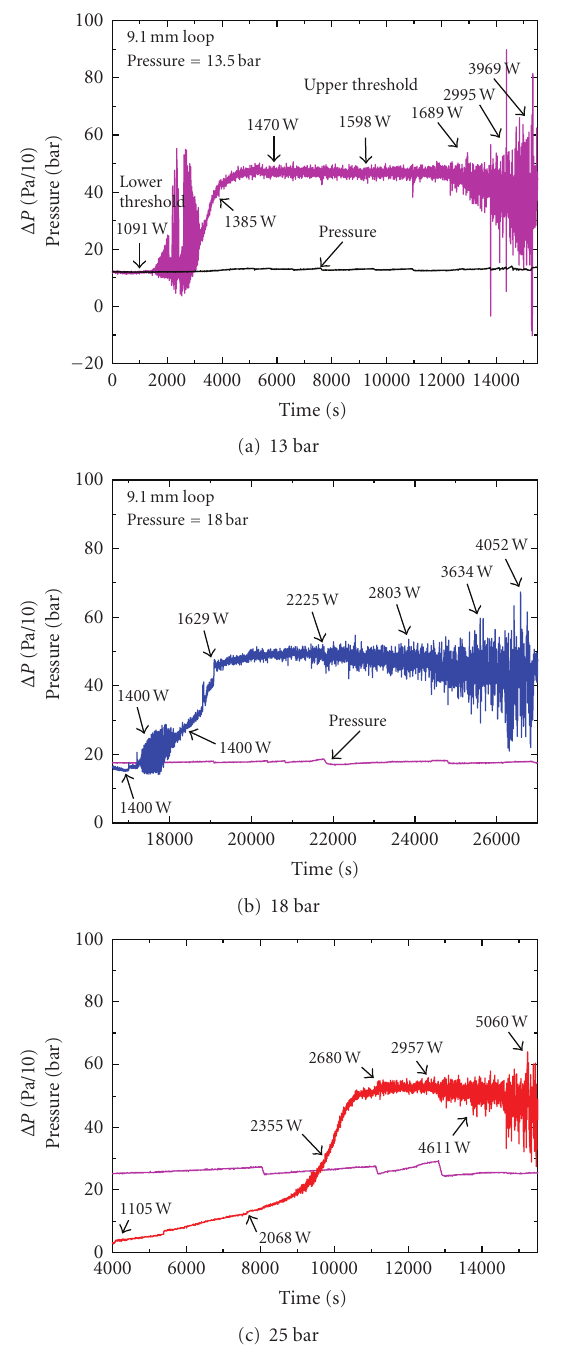
Figure 19: The upper threshold of instability at di ff erent pressures.